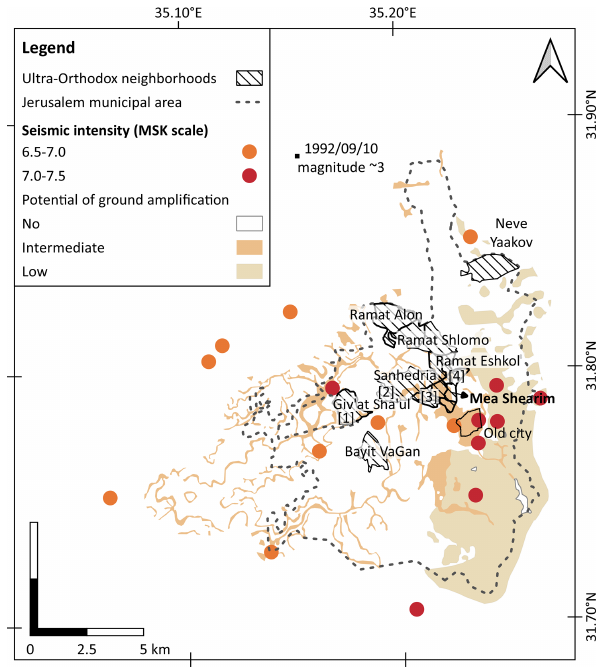
Figure 2. Map of ultra-Orthodox neighborhoods in Jerusalem (modified after Korach and Choshen, 2020; Golan-Agnon, 2020). An ultra-Orthodox neighborhood is defined as a neighborhood where over 50% of the Jewish population aged 15 or older are ultra-Orthodox (Korach and Choshen, 2020, p. 25). The background map outlines soil with a tendency to amplify shaking (Salamon et al., 2010). This is based on soil and rock classification and needs verification. [1] Har Nof, [2] Romema, [3] Ge’ula, [4] Shmuel HaNavi. The neighborhood Mea Shearim, associated with the ultra- Orthodox society, and the adjacent neighborhoods to the north and west are expected to suffer increased ground shaking. An instru- mentally located epicenter (1992, M > 3) is marked by a solid black square (https://www.gii.co.il/, last access: 10 January 2021). The Medvedev–Sponheuer–Karnik (MSK) intensity scale (colored cir- cles) evaluates the severity of ground shaking for a given location; the mean seismic intensity in Jerusalem during the 1927 M 6.2 Jericho earthquake ranged 6.5–7.5 on the MSK scale (Avni, 1999; Shapira et al., 1993; Hough and Avni, 2011). This scale corresponds roughly to the modified Mercalli scale (MMS) given at the bottom of Table